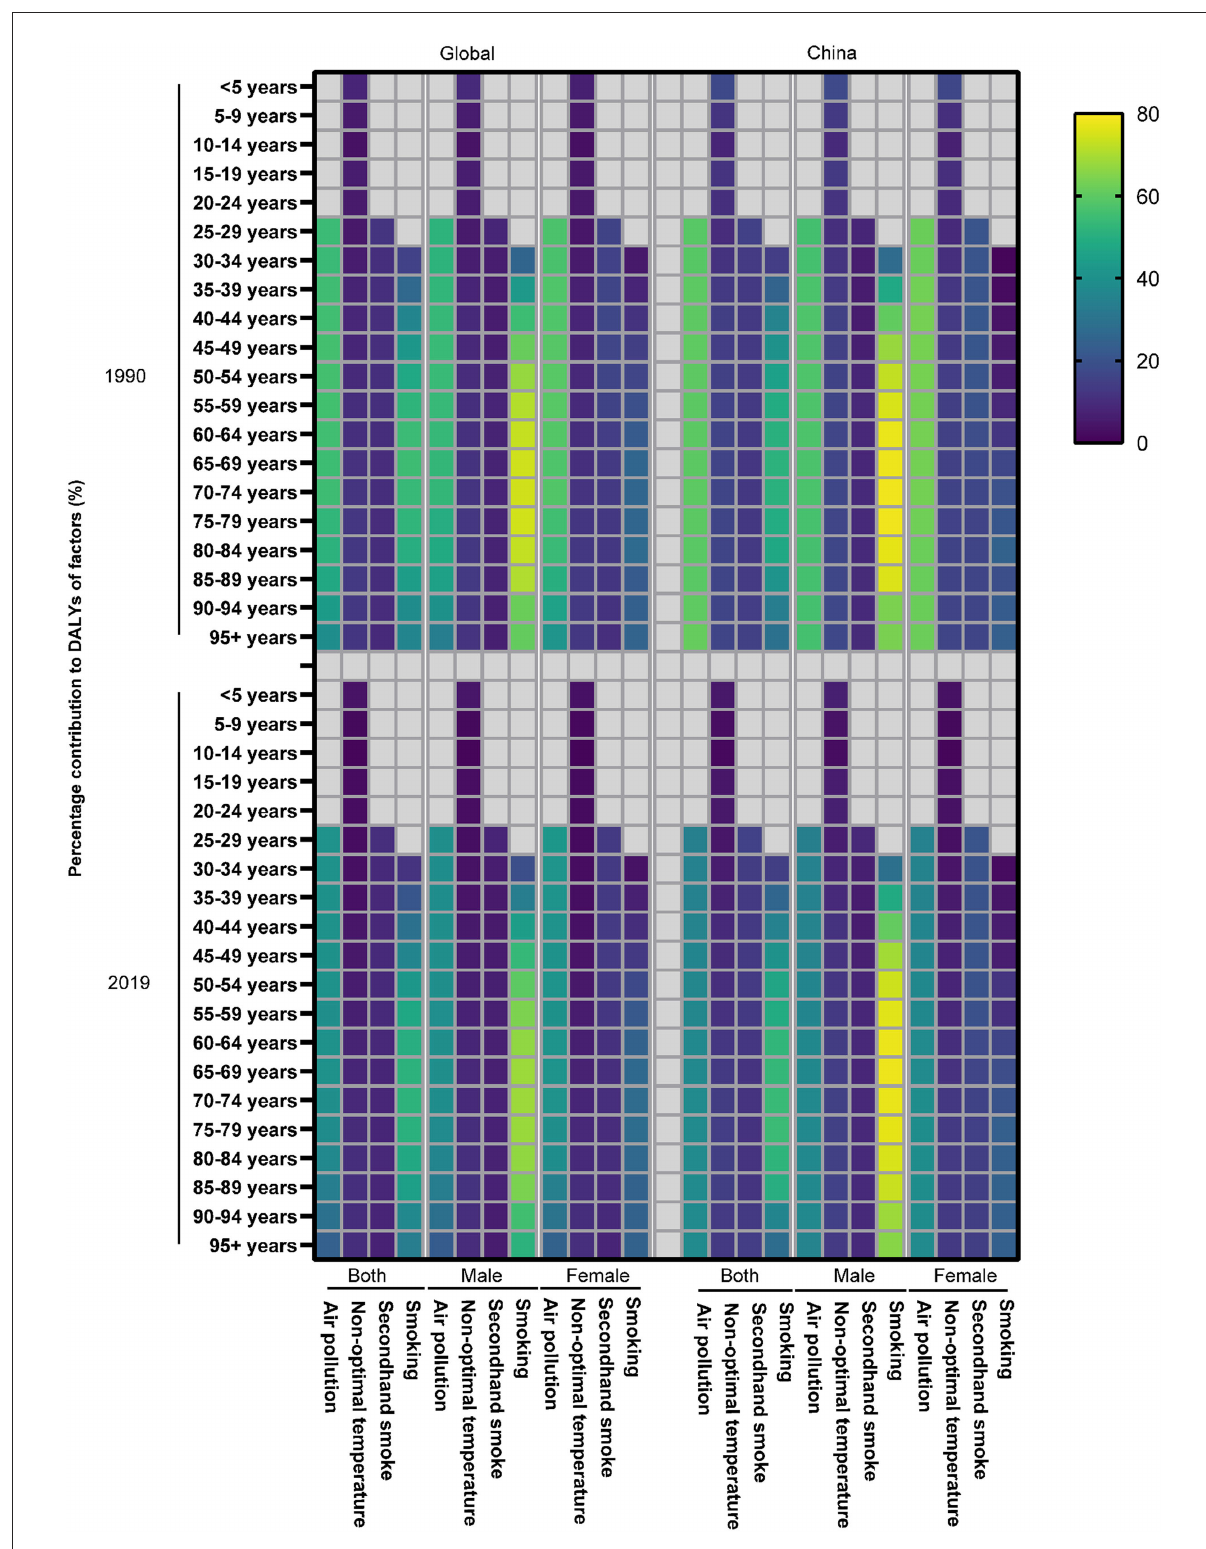
FIGURE5 The contribution of risk factors to DALY of COPD in 1990 and